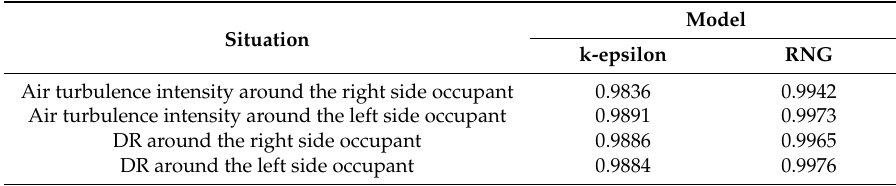
Table 5. Air turbulence intensity and DR accuracy obtained in the validations tests using the k-epsilon and RNG turbulence models.